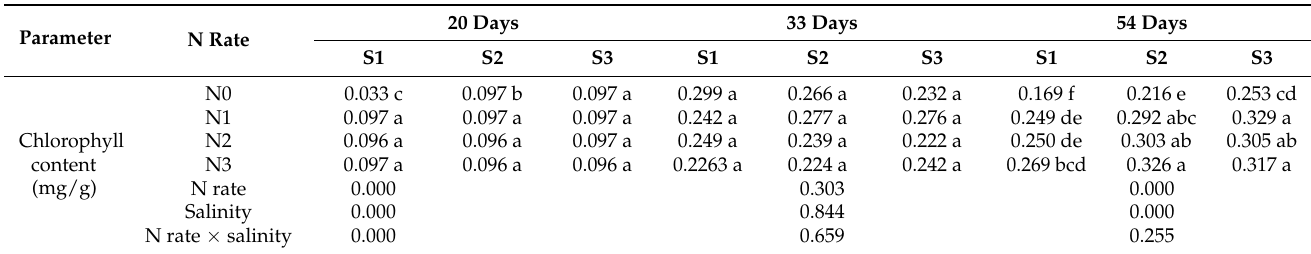
Table 5. Effects of nitrogen application rates with different soil salinity levels on chlorophyll content in different growth stages of winter